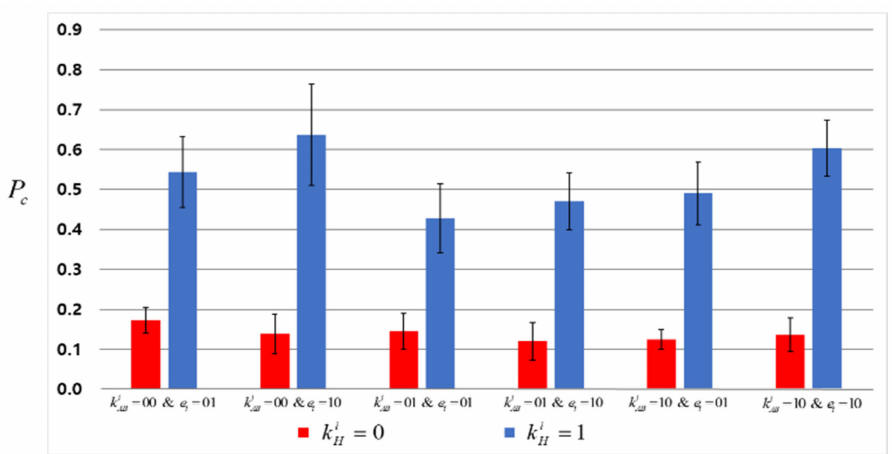
Figure 6. Coincidence probability by existential forgery. Red bars denote the case where Eve attempts original Gao’s Forgery when operator H is not used in the quantum encryption scheme (cid:16) (cid:17) = 0 k i . The blue bars show the case of attempting improved Gao’s Forgery when operator H H is used in the quantum encryption scheme bars indicate the standard deviation of the coincidence counts for 1 s. k i e i ∈ { 00, 01, 10, 11 } corresponds to the Pauli operator σ e Gao’s Forgery